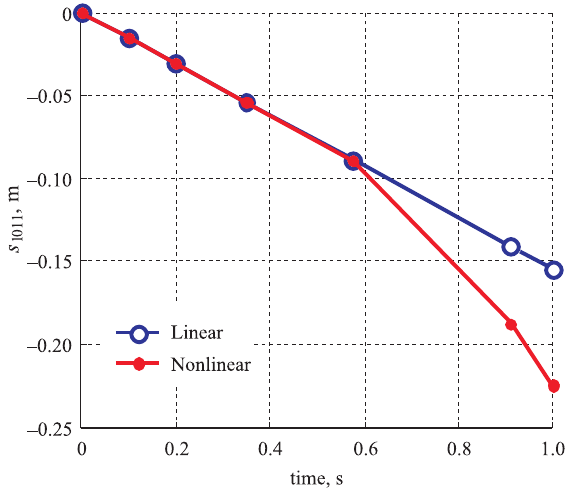
Fig. 15. Settlements s 1011 ( time ) of foundation node N1011 in load history with and without physical nonlinearity